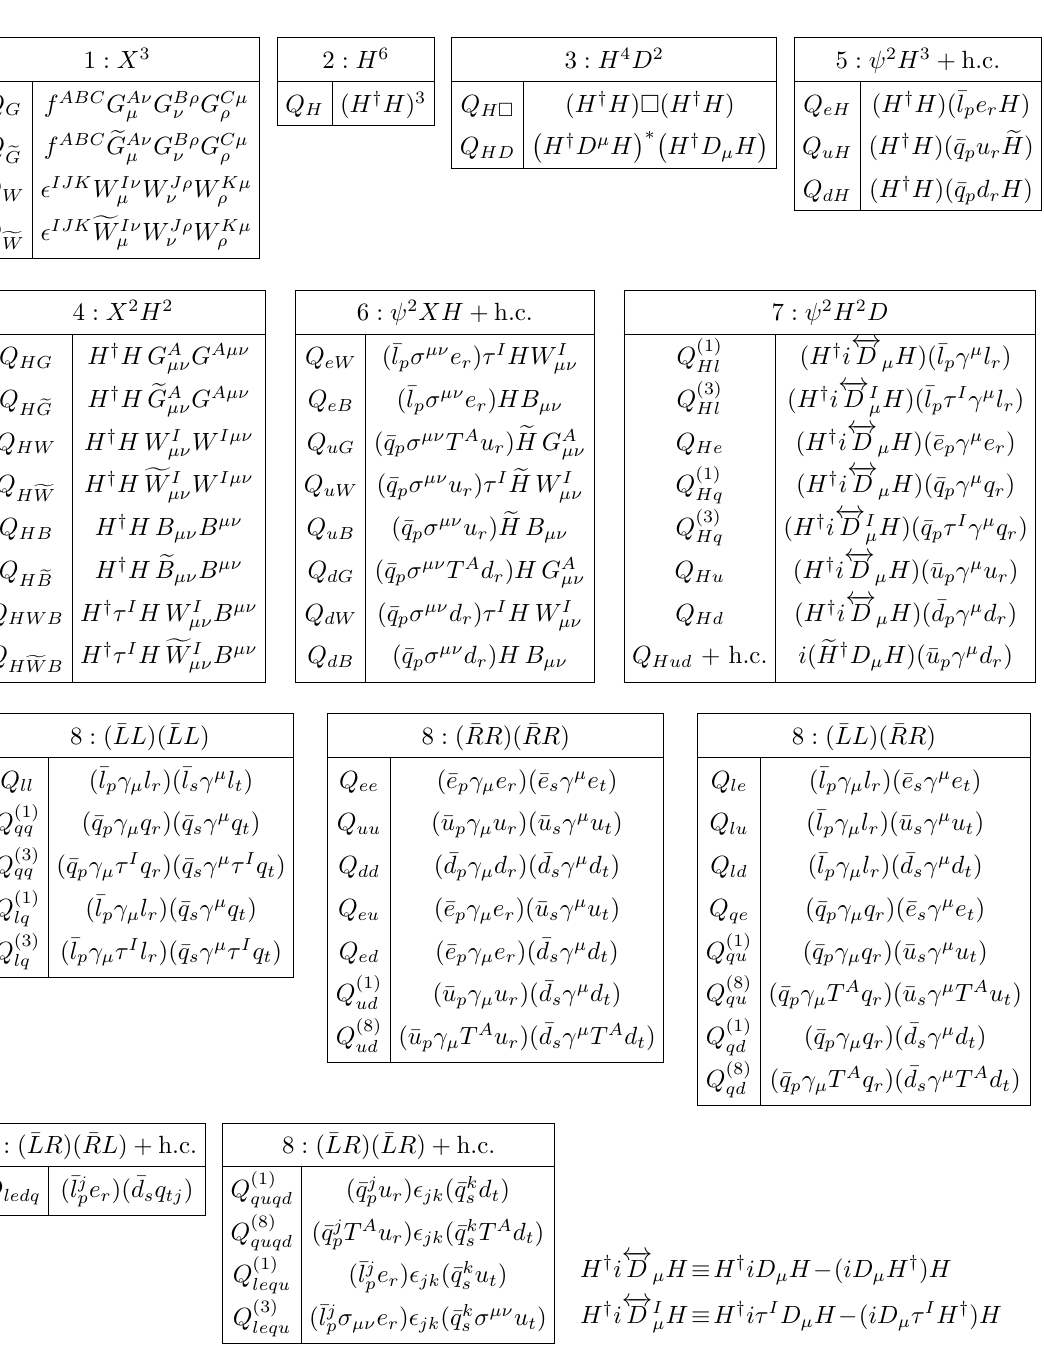
(6) operators built from Standard Model (cid:12)elds which conserve baryon number, as Table 10 . The L given in ref. [10, 19, 34, 35]. The operators are divided into eight Classes: X 3 , H 6 , etc. Operators with +h.c. in the table heading also have Hermitian conjugates, as does the 2 H 2 D operator Q Hud . The subscripts p; r; s; t are (cid:13)avour indices which are suppressed on the left hand sides of the